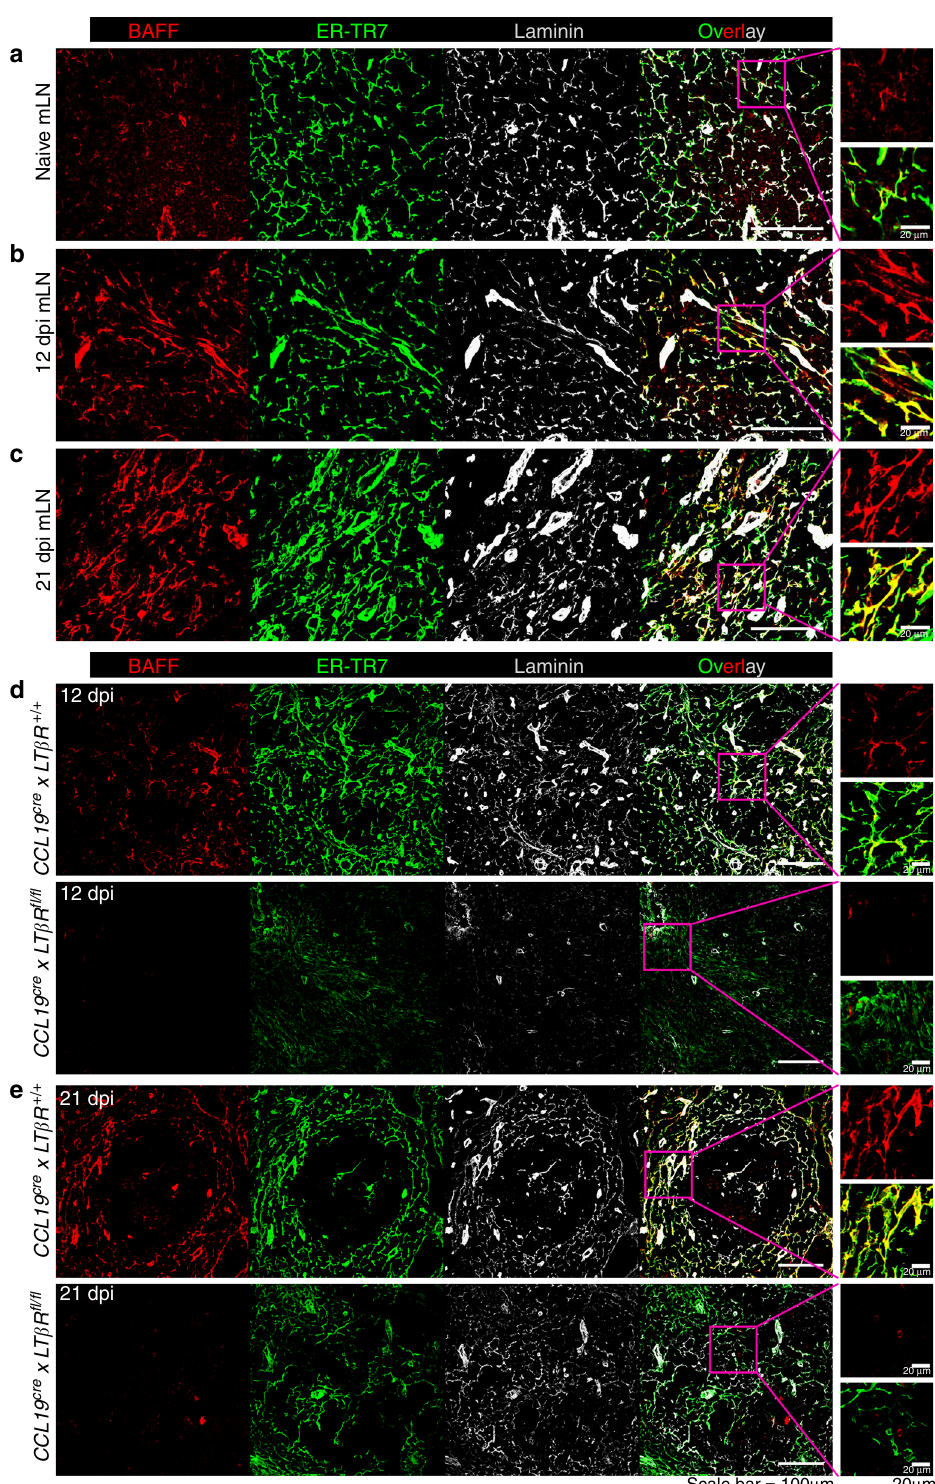
Fig. 5 Intestinal helminth infection activates FRCs surrounding B-cell follicles to produce BAFF in a LT β R-dependent manner. C57BL/6 J wild-type mice were infected with Hp and the entire chain of the mLN collected at the indicated time-points and processed for histological staining. a Naive, b 12 dpi and c 21 dpi Hp mLNs showing BAFF (stained with anti-BAFF antibody) expression by FRCs (ER-TR7 + laminin + ). BAFF expression in mLN FRCs in Hp -infected Ccl19 cre × LT β R fl / fl and Ccl19 cre × LT β R + / + mice at d 12 dpi and e 21 dpi Hp infection. Scale bar 100 μ m and 20 μ m. The magenta inset in the overlay panel is ampli fi ed and shown for BAFF alone ( red ) or for ERTR-7 + FRCs ( red + green ) expressing BAFF